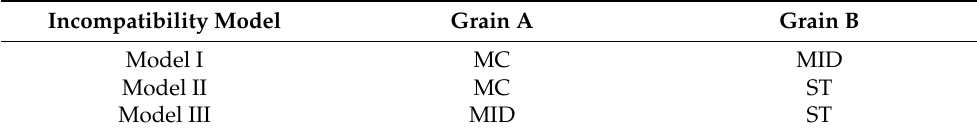
Table 2. Incompatibility bicrystal models with three types of